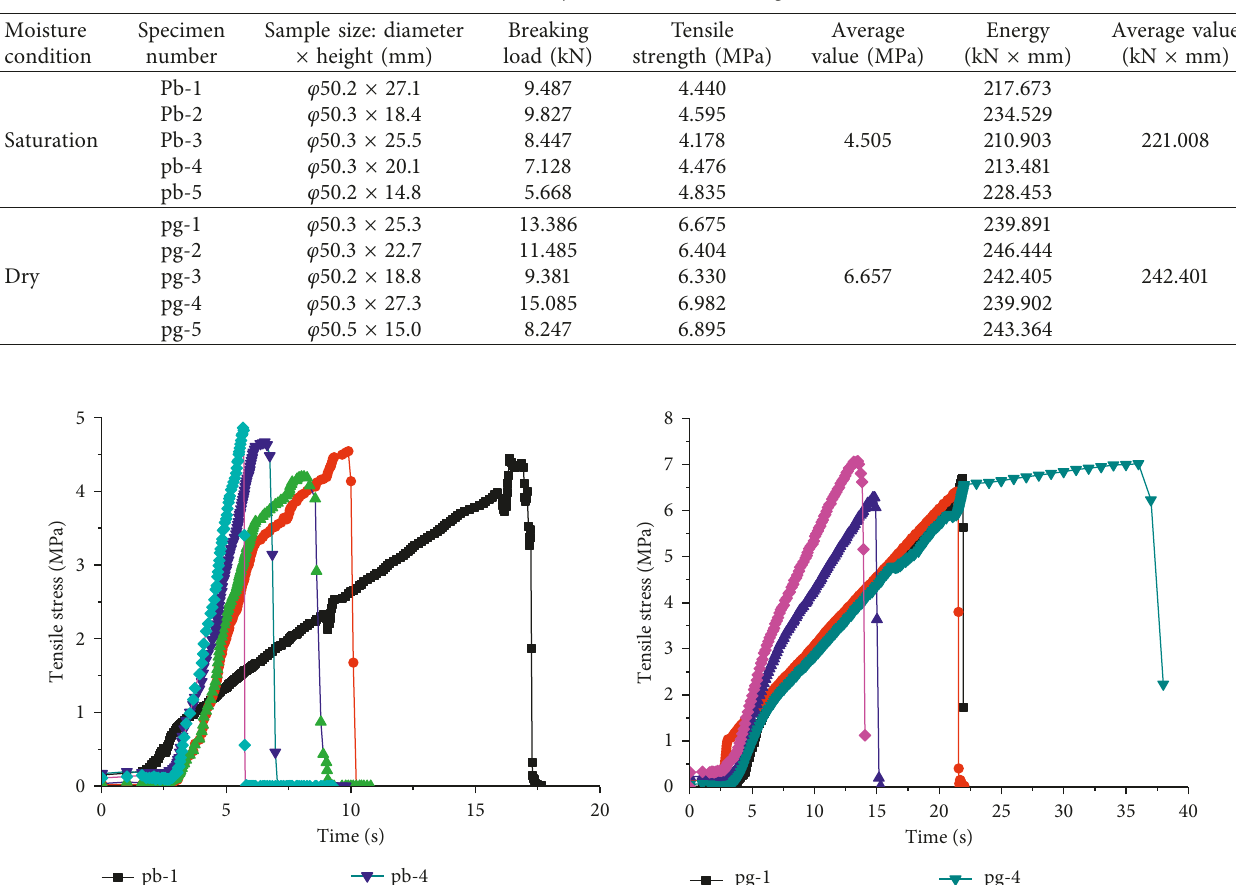
Figure 4: Schematic diagram of energy calculation. Table 1: Basalt columnar joints and tensile strength of the sheet.